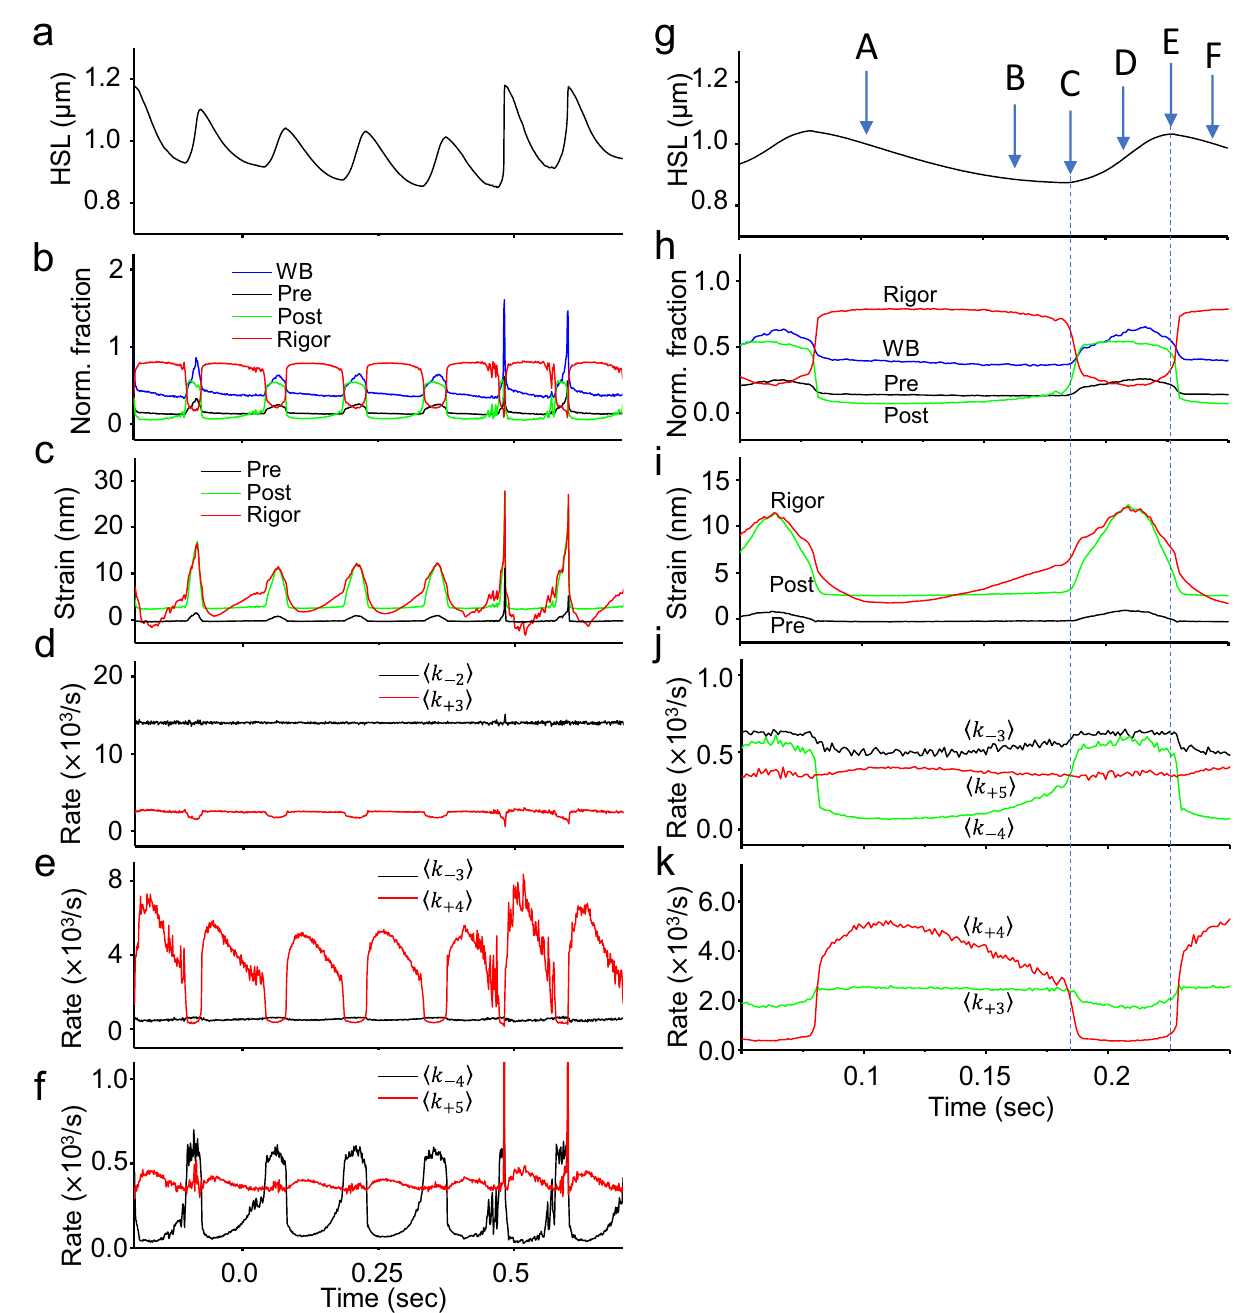
Figure 5. Parameter changes of the model that reproduces HSOs (part 2). The recording time was the same for ( a–f) and Fig. 4. (a) Changes in half-sarcomere length (same data as in Fig. 4a). ( b) The numbers of myosin molecules in the different states (Fig. 4c) were normalized by the number of active molecules. The colors are the same as in ( a ). ( c) Average strain applied to each myosin molecule in each state. The colors are the same as in ( a ). ( d–f) Rate constant of the state transition of myosin in each state. The vertical axis of the graphs shows the 1/1000 value. The constant for the transition from Pre to Post is < k +3 > , and that for the transition from Pre to WB is < k −2 > ( d ). The constant for the transition from Post to Rig is < k +4 > , and that for the transition from Post to Pre is < k −3 > ( e ). The constant for the transition from Rig to Det is < k +5 > , and that for the transition from Rigor to Post is < k −4 > ( f ). ( g–k) Enlarged views of (a–f) from 0.05 to 0.25 s. The enlarged view of (d–f) was reorganized into two panels except for < k −2 > . A–F are symbols for explaining the mechanism of HSOs in the